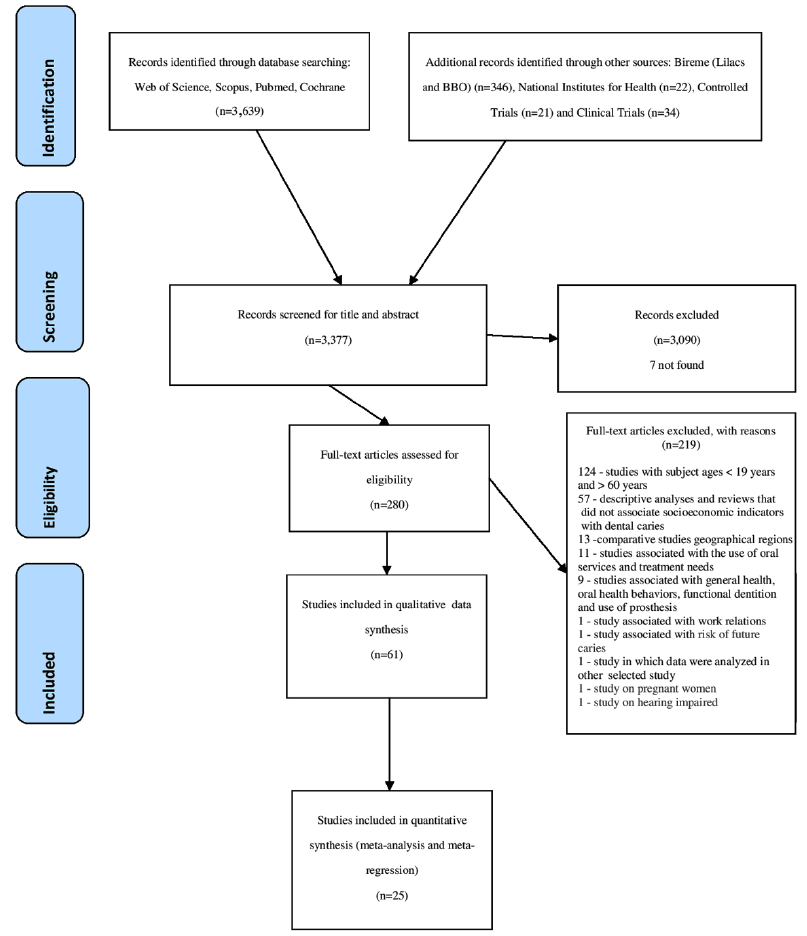
Figure1. Flowchart of the search process according to PRISMA guidelines. Figure 1. Flowchart of the search process according to PRISMA